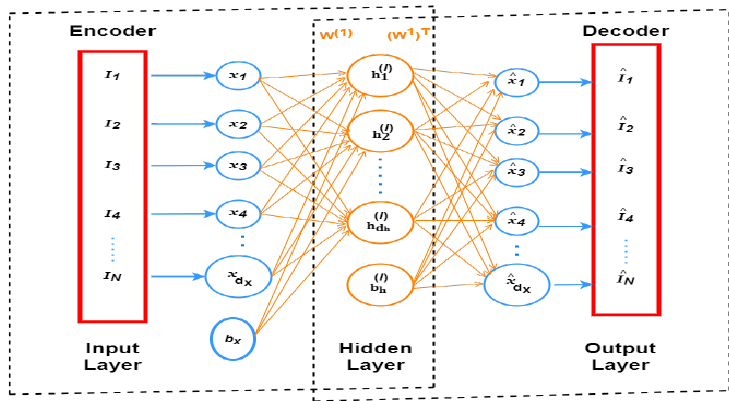
Figure 9. The simple sparse autoencoder architecture.